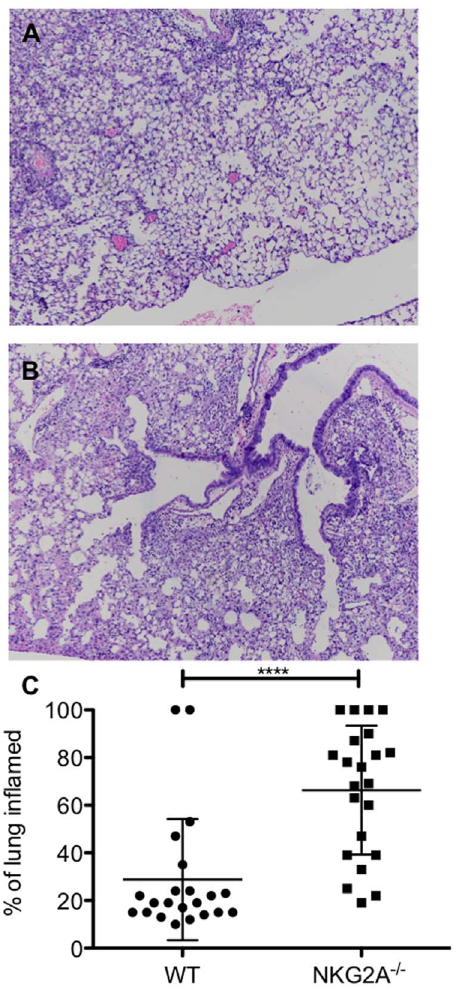
Figure 5. NKG2A 2 / 2 mice demonstrate greater lung damage from enhanced inflammation during acute influenza infection. Mice were intranasally infected with a sub-lethal dose of influenza A/ PR8/34. On day 10 post-infection, mice were euthanized by anesthesia overdose and exsanguination. Lungs were process as in materials and methods for histological sections, slides were H & E stained and evaluated for histopathological damage. Percent of total area of damaged lung per 4 6 field was calculated for each lung slice. Data is presented as % inflamed lung. Data is representative of two distinct experiments of 2–4 mice per group. **** p ,